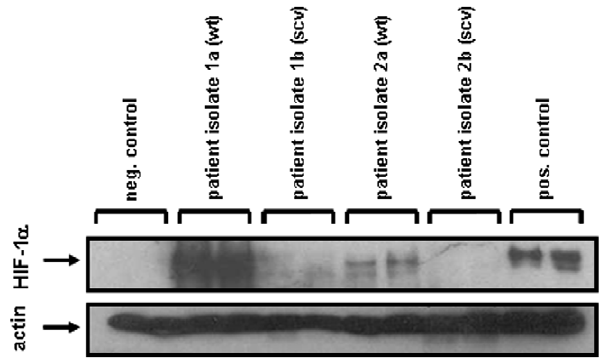
Figure 6. Induction of HIF-1 activation in HeLa-229 cells by S. aureus patient isolates (wild-type and the respective small colony variants). The HIF-1 a protein was analyzed in Western blots six hours upon infection (loading control: actin). The following patient isolates were used: S. aureus patient isolate 1 (wt; S. aureus A22223 I), S. aureus patient isolate 2 (clinical SCV; S. aureus A22223 II), S. aureus patient isolate 3 (wt; S. aureus OM 1a), S. aureus patient isolate 4 (clinical SCV; S. aureus OM 1b). Negative control: uninfected cells, positive control: hypoxia. Multiplicity of infection (MOI): 20.